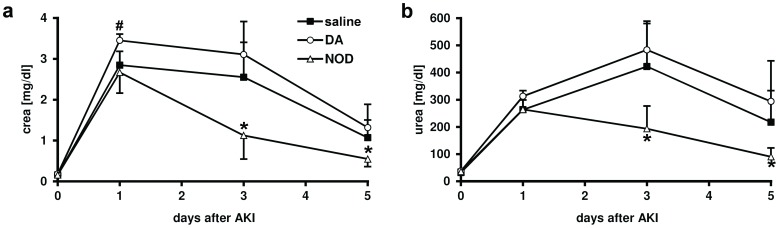
Renal function after induction of acute renal failure.
A. Serum creatinine revealed a significantly improved renal function in the NOD group compared to the dopamine treated group (DA) at day 1 (#NOD vs. DA; P<0.01). Creatinine levels at day 3 and 5 after induction of AKI were significantly lower in NOD than both dopamine and saline control group (*NOD vs. DA/NaCl;P<0.001). B. Similar results could be observed by serum urea measurements. NOD showed significantly lower levels on day 3 and 5 (*NOD vs. DA/NaCl; P<0.001).